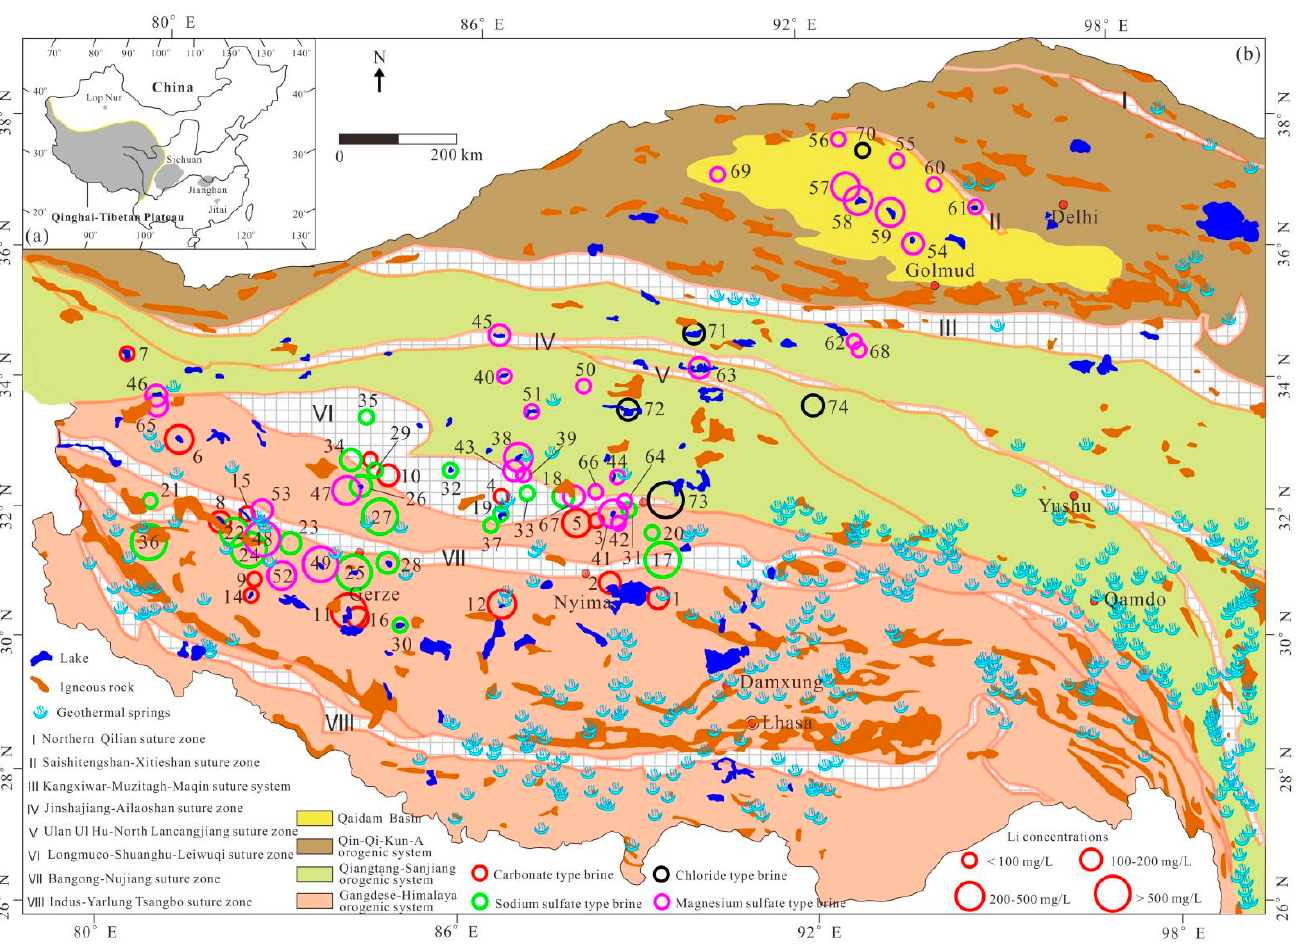
Figure 1. ( a ) Map showing the location of Qinghai-Tibetan Plateau (QTP); ( b ) the distribution and Li concentrations of salt lakes on the Qinghai-Tibetan Plateau. The location of geothermal springs is from [12]; the distribution of suture zones and orogenic systems is from [13]. The name and Li concentrations of salt lakes can be seen from Table 1.